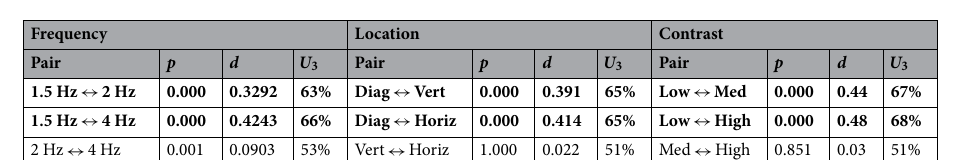
Figure 6. Average visibility results. The ranking shows the relationship between the groups with respect to frequency (Left) and in terms of angular distance (Right). Each blue circle represents a tested condition and they are ordered according to their ranking, with the least preferred condition on the left. The x-axis represents the rating of each condition, expressed as the mean number of votes, i. e. mean visibility of the disks with given setup. The percentages indicate the probability that an average observer will regard the condition on the right as better than the condition on the left. If the line connecting two conditions are red and dashed, there is no statistical difference between this pair of conditions ( H 0 could not be rejected at 0.05 level). The small-font number in square brackets indicates the p value of the t test between both conditions (without compensation for multiple comparisons).